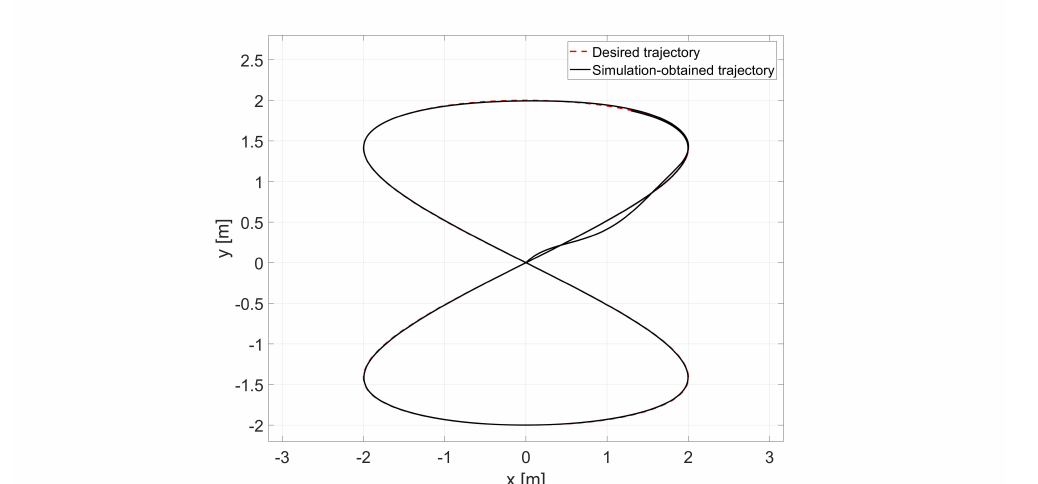
Figure 7. Comparison of the desired trajectory and that obtained by simulation for the Levenberg- Marguardt method.